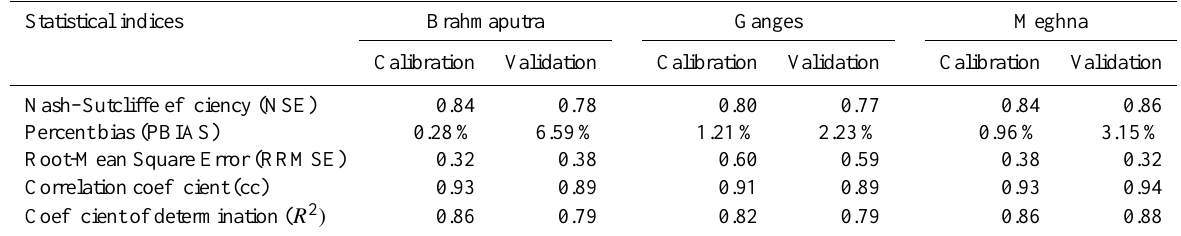
Table 4. Statistical indices that measure the model performance in the three basins (GBM) during both calibration and validation periods. Statistical indices